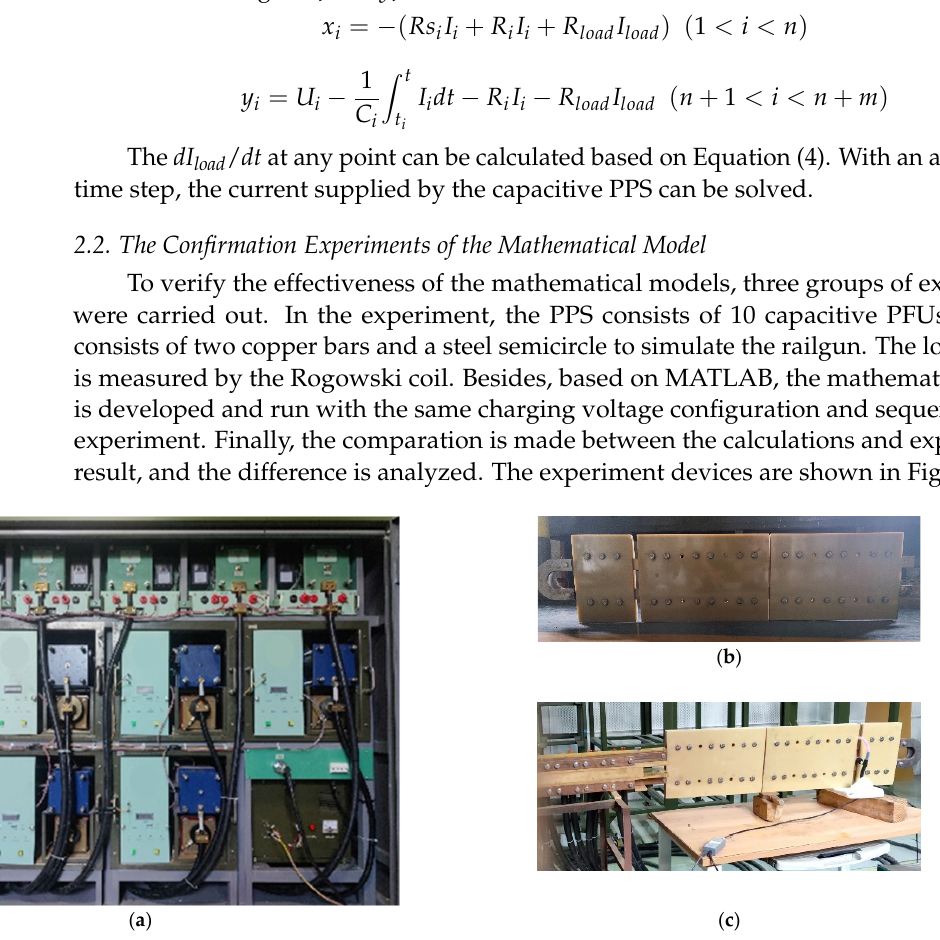
Figure 4. The experiment devices. ( a ) The capacitive power supply and the charger. ( b ) The load in experiments. ( c ) The connection of experimental devices.